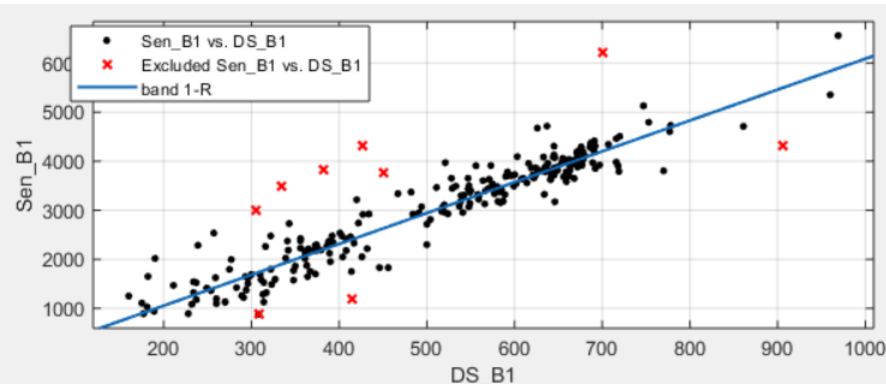
Figure 4. A plot showing outliers and linear function fitting on Band-1 data w.r.t base tile ’Sen-B1’ and adjoining tile ’DS-B1’. The linear function developed for mapping adjoining tile to base tile with a function y = 6.294x − 203.2.